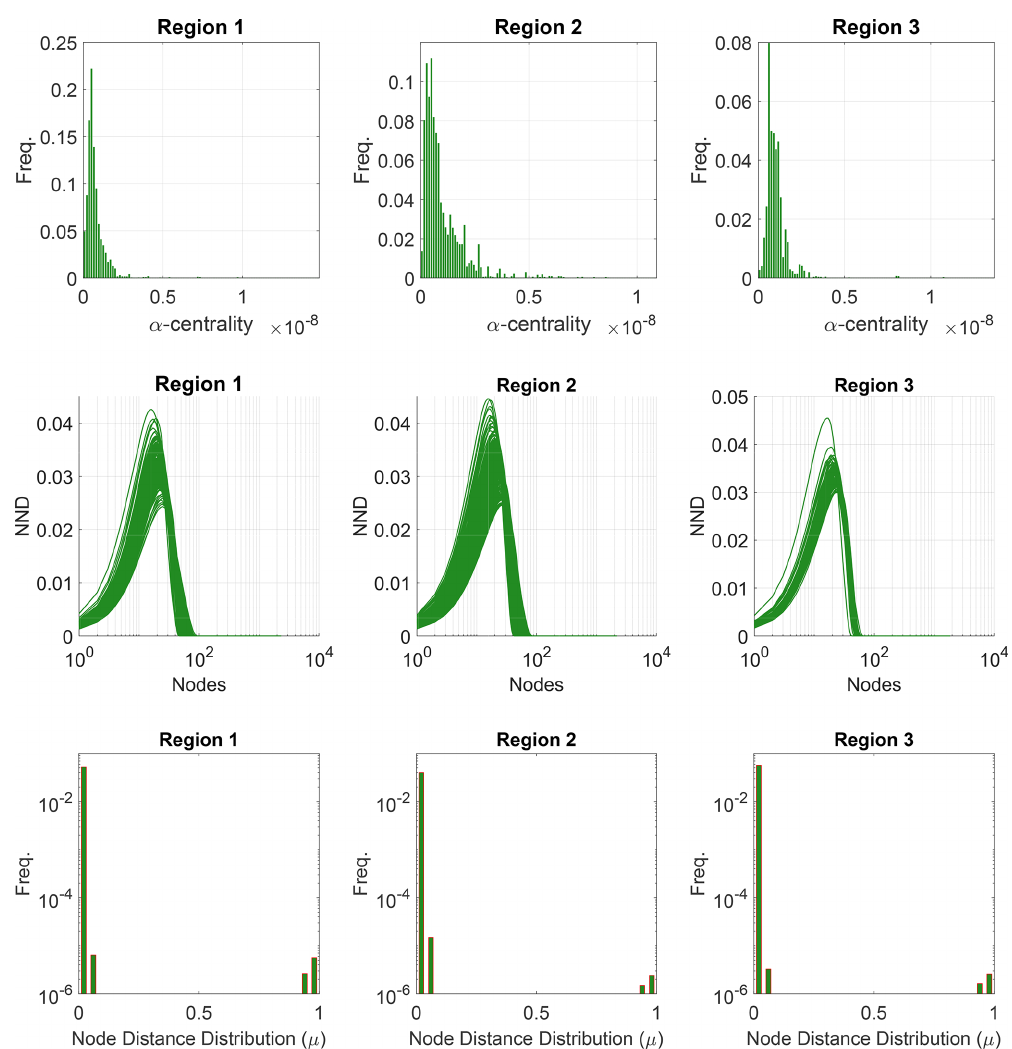
Figure 16. Region-wise properties used to compute the D-measure represented as ensemble plots of α centrality, network node dispersion (NND), and node distance ( µ ) distributions for